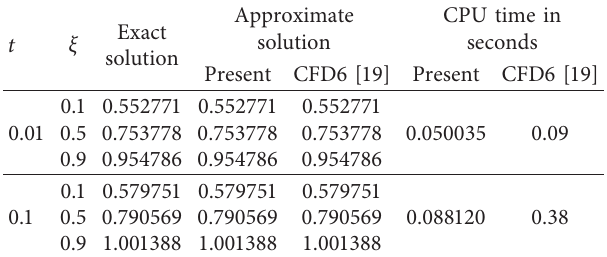
Table 1: The comparison of results for Test Problem 4.1 for dif- ferent values of t and ξ